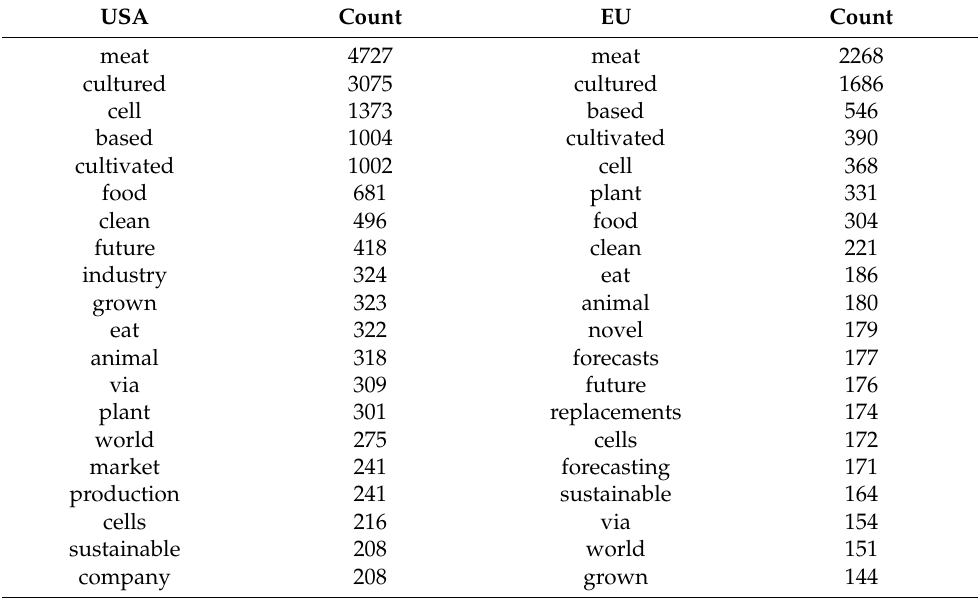
Table 3. Top 20 words in Tweets, based on regional difference (USA and EU).